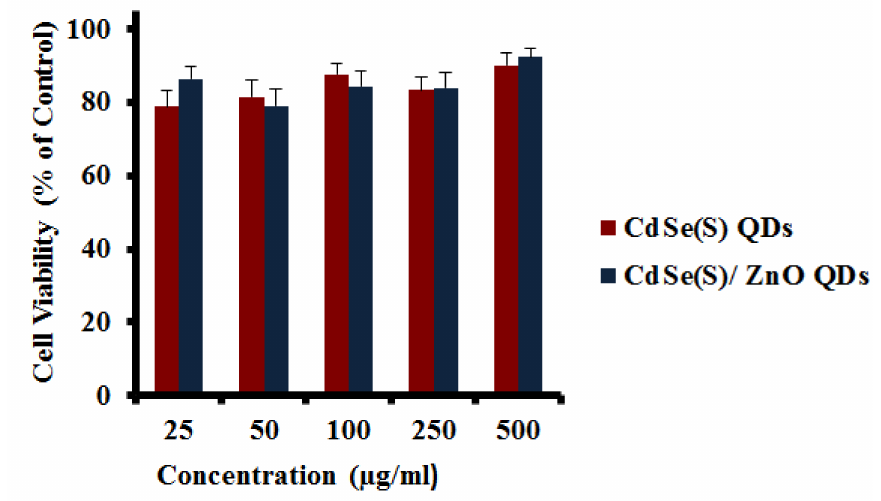
Figure 8. The results of cytotoxicity assays of CdSe(S) and CdSe(S)/ZnO QDs towards human skin fibroblast (WS1) cell line. Error bars indicate standard error of the mean and cell media without treatment with QDs was used as a